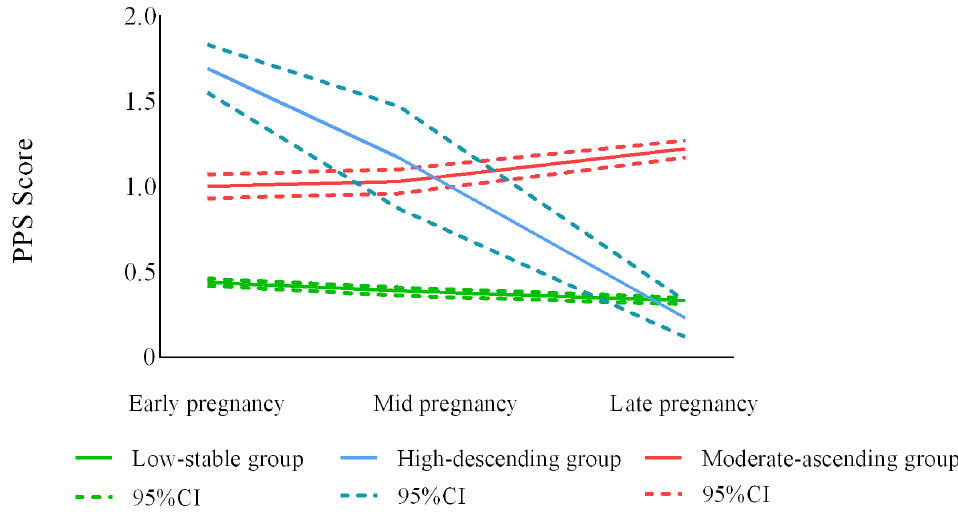
Figure 1. Optimal model trajectory curves for prenatal stress (n = 916).